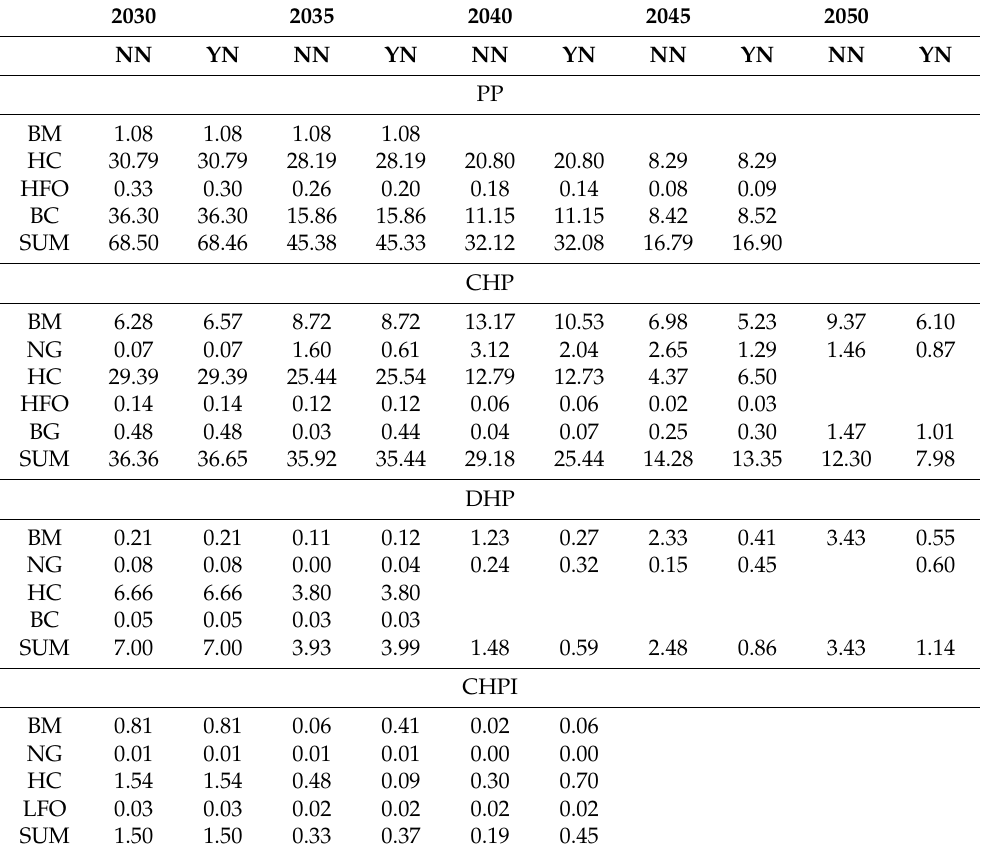
Table 6. Emission of NO x between 2030 and 2050 from various fuels (BM: biomass, HC: hard coal, HFO: heavy fuel oil, BC: brown coal, LFO: light fuel oil, NG: natural gas, BG: biogas) from public power plants (PP), public combined heat and power plants (CHP), district heating plants (DHP), and industrial combined heat and power plants (CHPI), for non-nuclear (NN) and nuclear (YN) scenarios (kt). A blank field in the table means that a respective fuel is not used in a given model